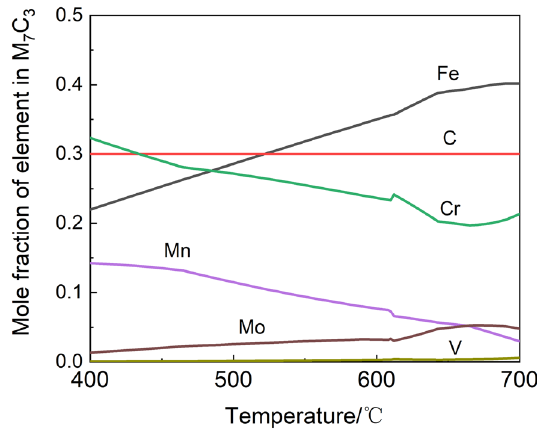
Figure 2: The element mole fraction of M7C3 in 5CrNiMoV steel.